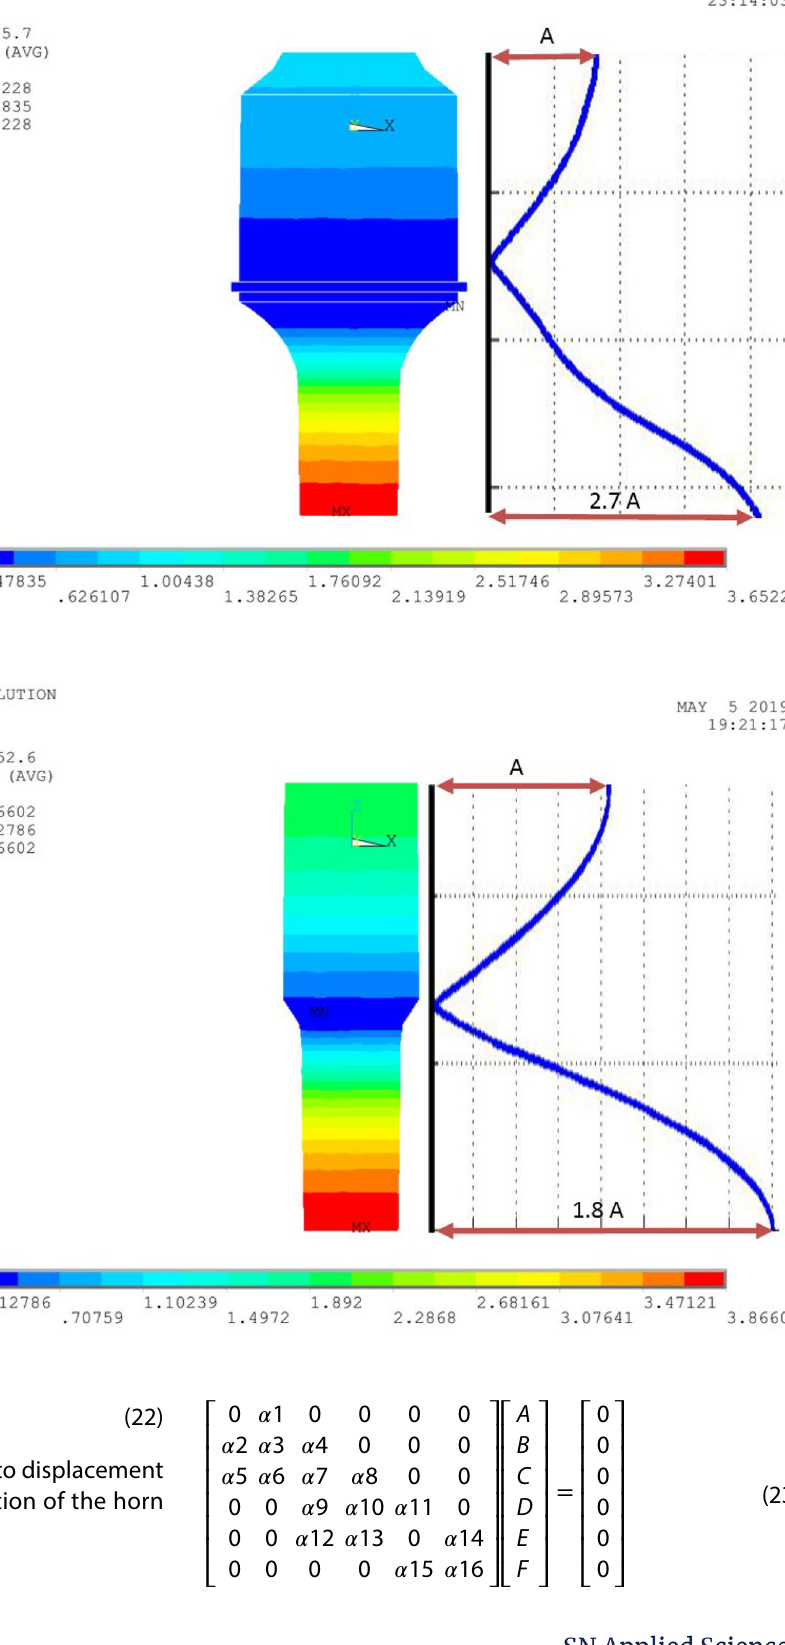
Fig. 7 Booster’s mode shape of the first longitudinal resonance frequency at 19,945.7 Hz